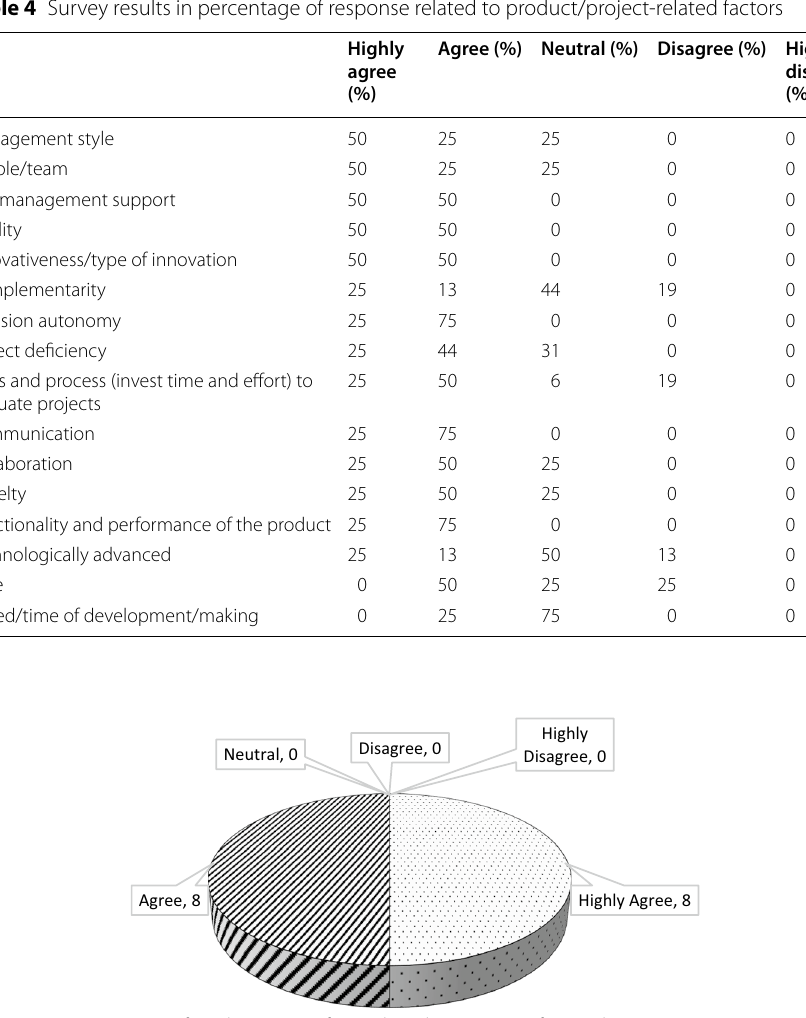
Fig. 7 Survey response of product/project factors by Pakistani ICT